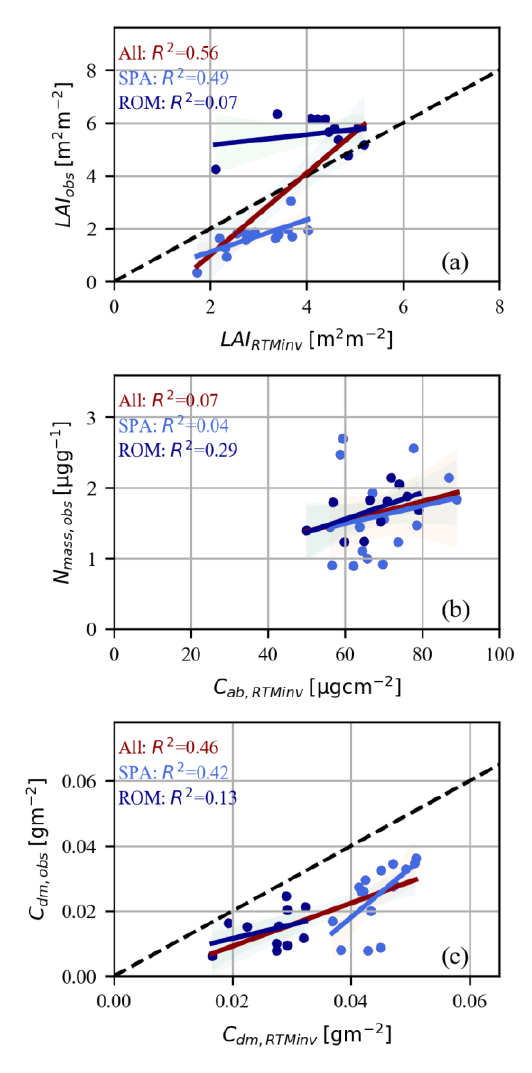
Figure 2 . Evaluation of estimated parameters (subscript 285 “RTMinv”) with field measurements (subscript “obs”).